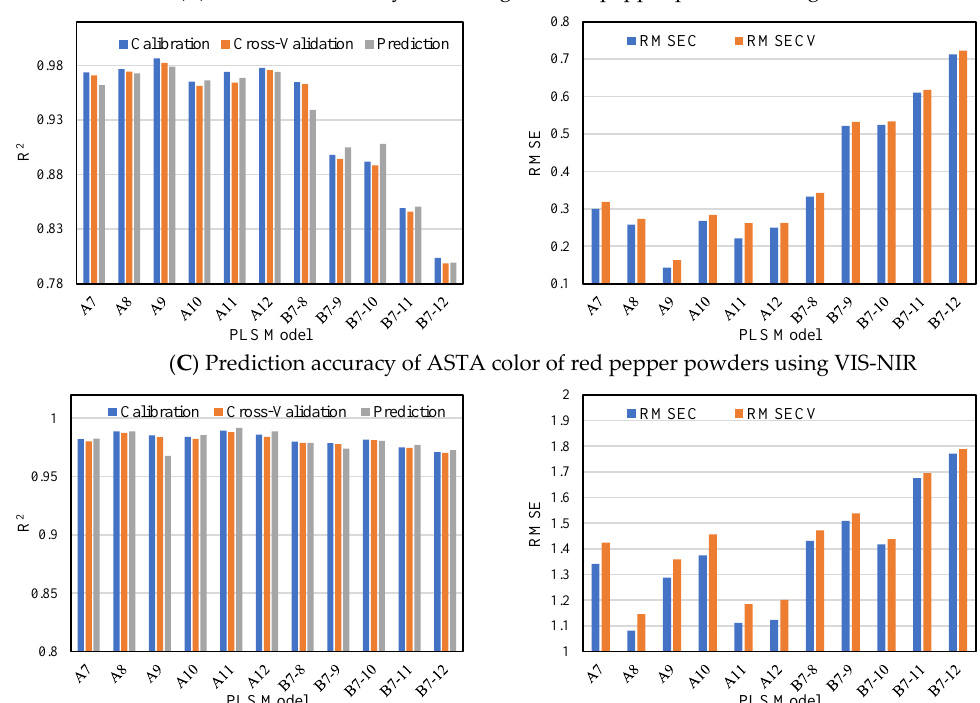
( B ) Prediction accuracy of free sugar of red pepper powders using VIS-NIR